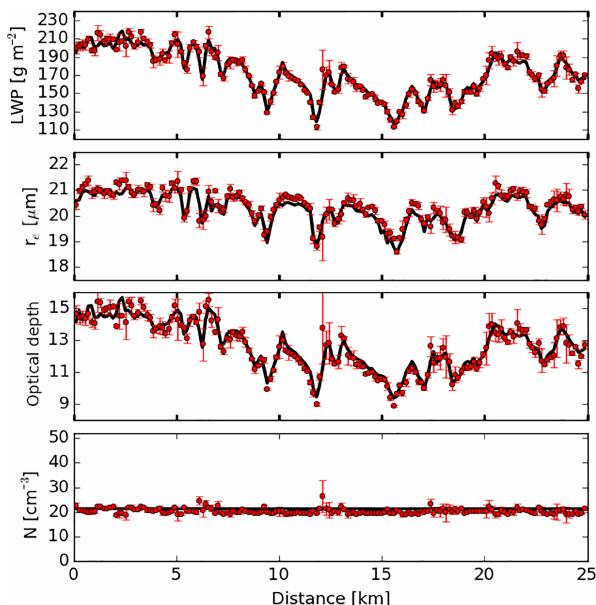
Figure 5. Microphysical and optical properties collapsed along the vertical axis: N is column averaged; LWC and α are integrated into LWP and optical depth, respectively; and r e are vertically averaged with the corresponding α as the weights. The black line represents the truth and the circles are the retrieved values. The error bars de- note the random errors obtained from the Monte Carlo